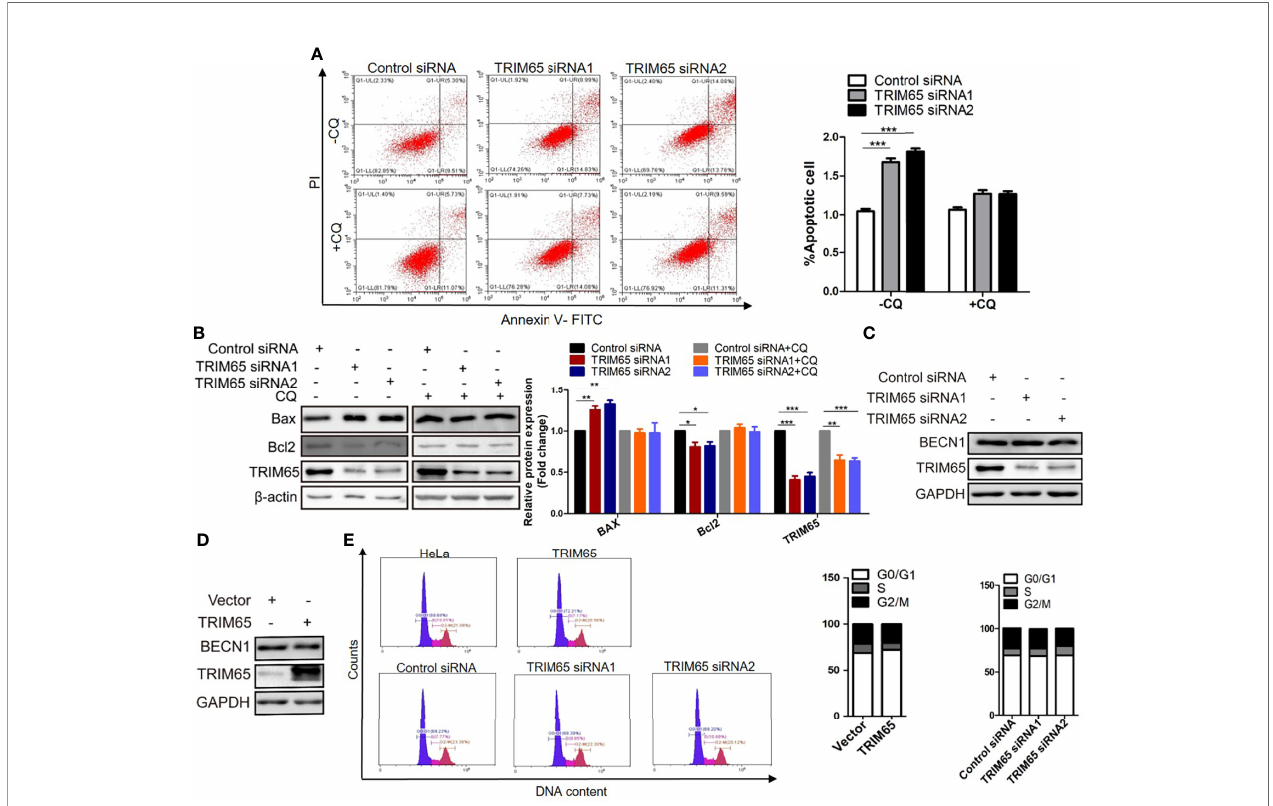
FIGURE 4 | The effect of TRIM 65 on the cell apoptosis and cycle. (A) Cells were transiently transfected with siRNA-NC or siRNA-TRIM65. 42 h later, the cells were treated with or without 20 m M CQ for 6 h, then the cell apoptosis was analyzed by Annexin V/PI staining. Bar diagram represents percentage of apoptotic cells. NC, negative control. (B) Bax and Bcl 2 were detected in the presence or absence of CQ by Western blotting. Relative protein expression over b -actin was quanti fi ed, and the statistical data was shown (Right panel). The expression of BECN1 was analyzed by western blot in HeLa cells with TRIM65 knockdown (C) or overexpression (D) . (E) Cell cycle pro fi le was analyzed using fl ow cytometry in cells with TRIM65 knockdown and overexpression. Data are presented as mean ± SD. The experiments were repeated three times independently and the data of one representative experiment was shown. *p < 0.05; **p < 0.01, ***p <